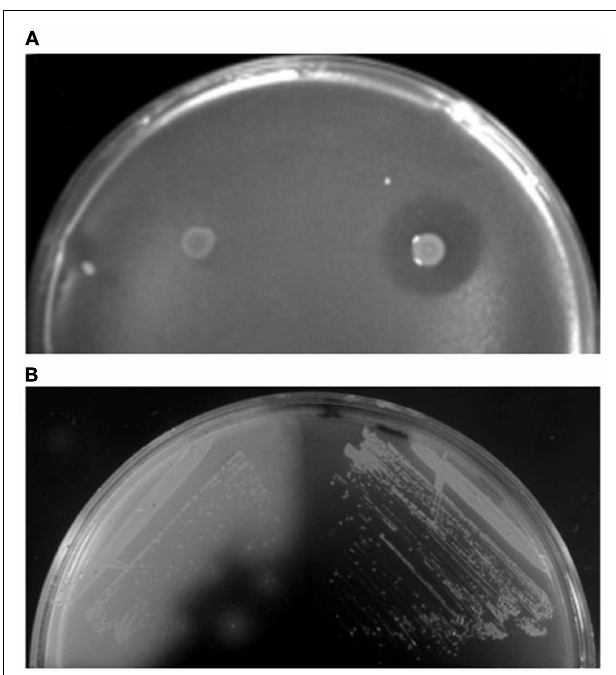
FIGURE 2 | Detection of extracellular protein activities. (A) Overlay assay with colonies of S. acidocaldarius wt (right) and ∆ sulAB mutant (left) grown on a lawn of S. solfataricus strain P2. Clear halos surrounding the colonies indicate killing of archaea by the sulfolobicins. Image reproduced with permission from Ellen et al. (2011). (B) Iodine vapor staining of H. volcanii expressing wild-type (left) or signal sequence mutated (right) α -amylase grown on rich medium supplemented with 0.2% soluble starch. Clear halos surrounding colonies indicate starch hydrolysis by extracytoplasmic α -amylase (Rose et al.,